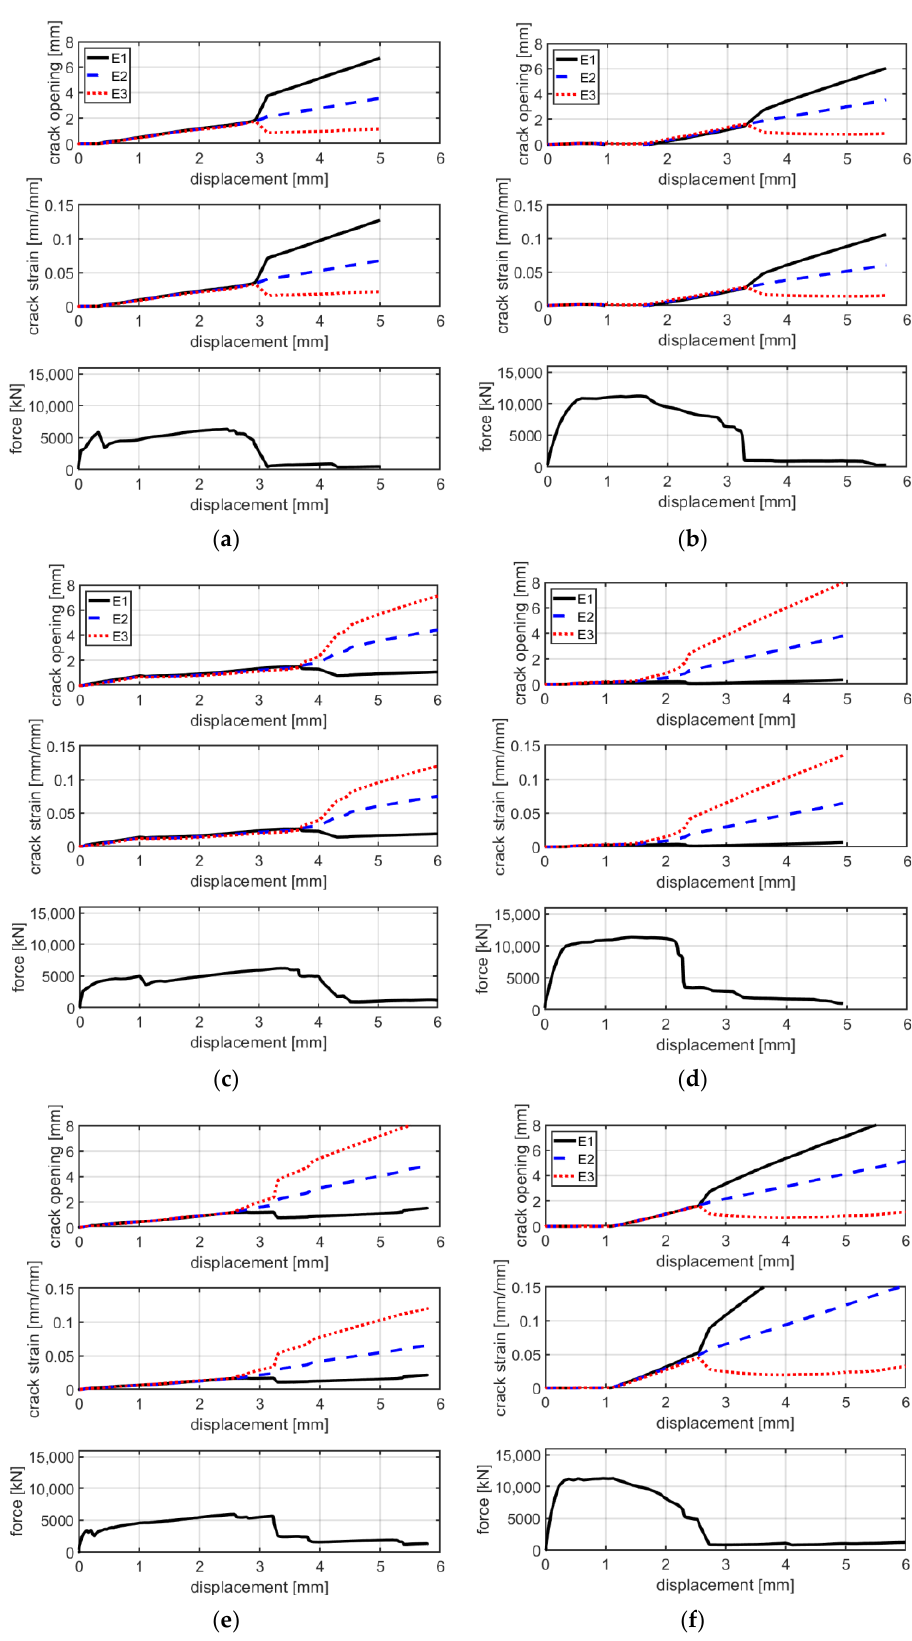
Figure 7. Comparison between crack opening, crack strain and axial force with the axial displacement of specimen BP-1-A ( a ), BP-2-A ( c ), BP-3-A ( e ), BPf-1-A ( b ), BPf-2-A ( d ) and BPf-3-A- ( f